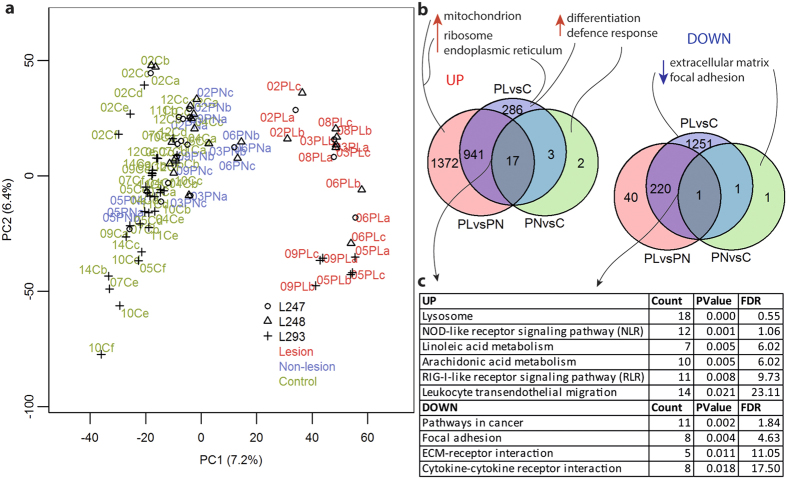
Expression profiling of lesional and non-lesional psoriatic and control skin by RNAseq.(a) Principal component analysis demonstrates clustering of the spike-in normalized sample groups PL (red), PN (blue), and C (green). Percentages are contribution ratios. The three libraries have different symbols; L247 and L248 indicate Run1 and L293 Run2 (description in Supplementary Table S1) (b) Venn diagram of DEGs from the three comparisons: PLvsPN, PLvsC, and PNvsC (FC > 1.5 or < 0.75, FDR < 0.05). The most significant GO categories are shown (red arrow indicates up- and blue downregulated). (c) Enriched KEGG pathways of DEGs that are common to the PLvsC and PLvsPN comparisons (FDR < 0.25).